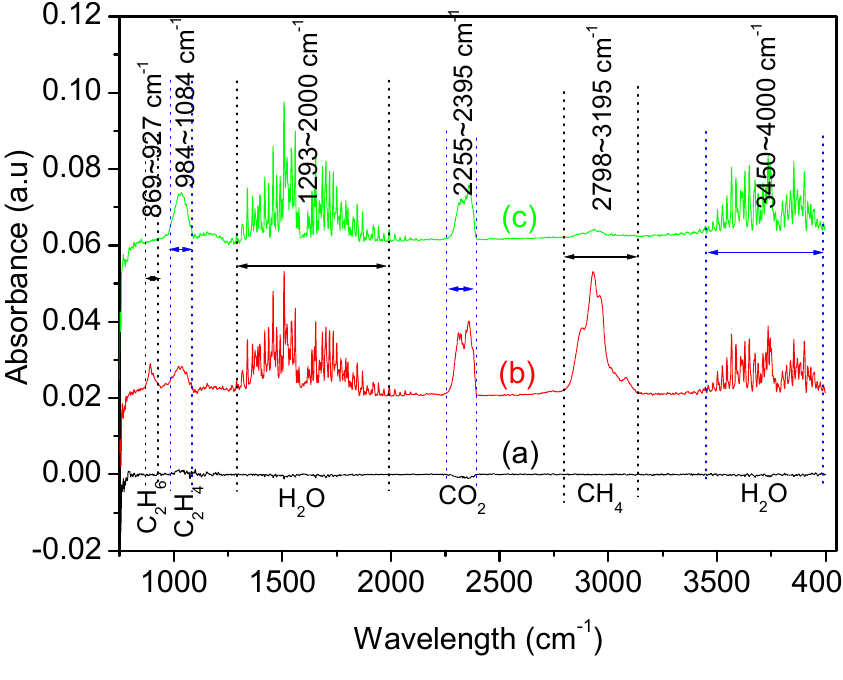
Figure 4. The 3D infrared spectrum of evolved gases during the pyrolysis of polymeric waste latex between 50 and 1000 °C at a heating rate of 20 °C/min: ( a ) 50 °C, ( b ) 387 °C, ( c ) 1000 °C. Table 1. Quantitative gas analysis during heat treatment of latex at horizontal tube furnace for 15 min at three di ff erent